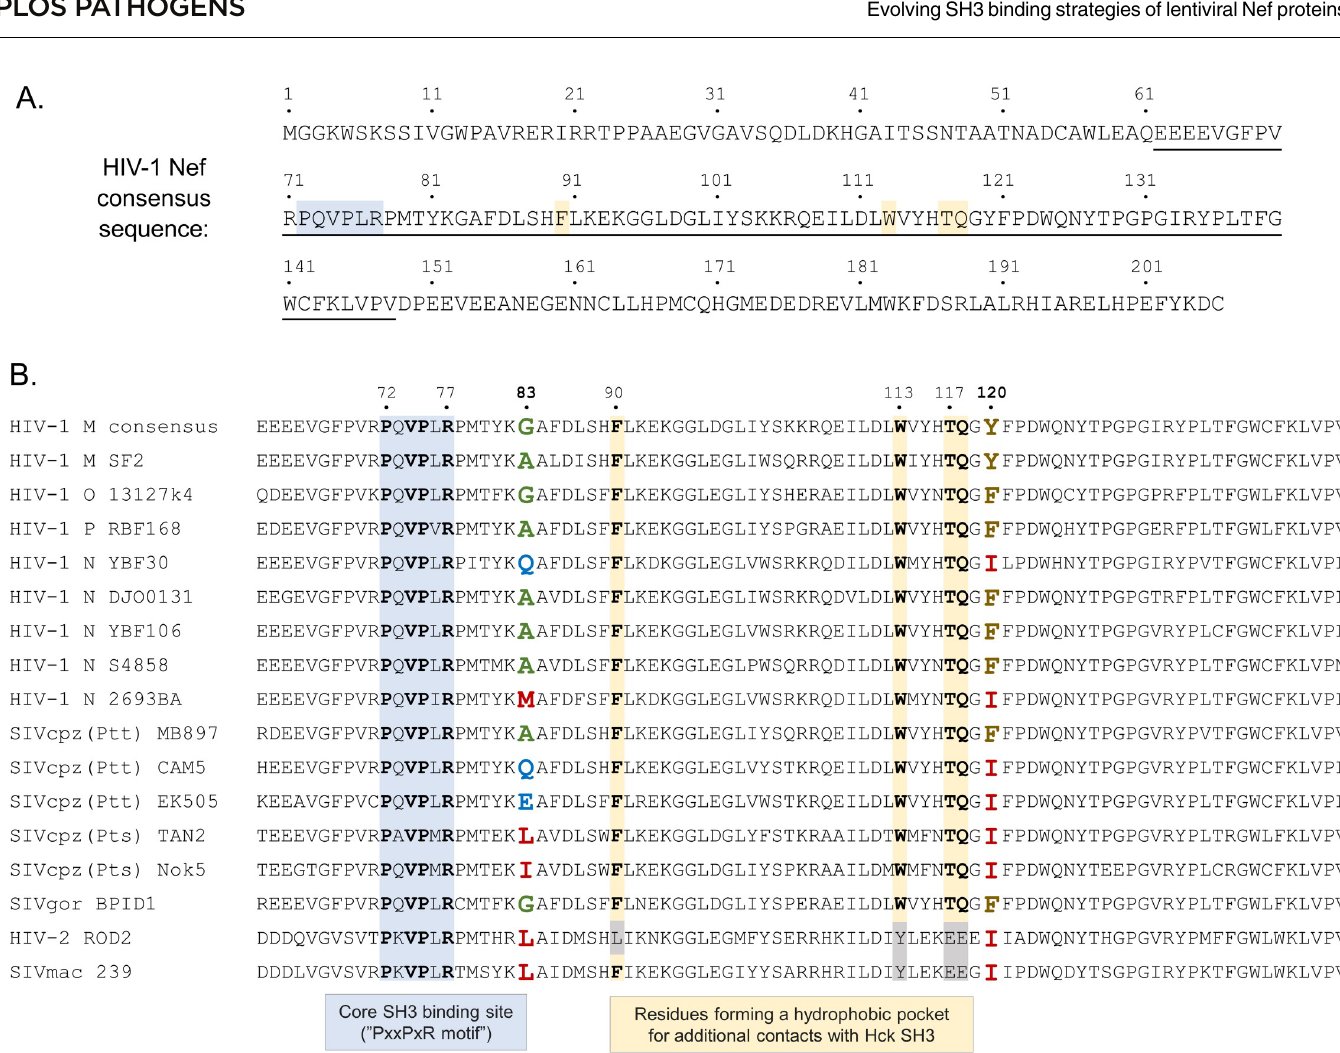
Fig 2. HIV-1 M consensus Nef amino acid sequence (A) and an alignment of the conserved central region (underlined in A) of selected Nef proteins from different primate lentiviruses (B) . The key residues of the core SH3 docking site (PxxPxR motif), including R77, are highlighted in light blue. Residues involved in a binding pocket for the Hck SH3 domain RT-loop that are conserved in HIV-1 and HIV-1-like Nef proteins are highlighted in yellow. Residues at positions 83 and 120 forming the R-clamp coordinating the positioning of R77 are shown in bold and colored according to their side chain properties (small in green, hydrophilic in blue, aliphatic or methionine in red, aromatic in brown). The names of HIV/SIV strains from which Nef proteins were included in this study are shown on the left.